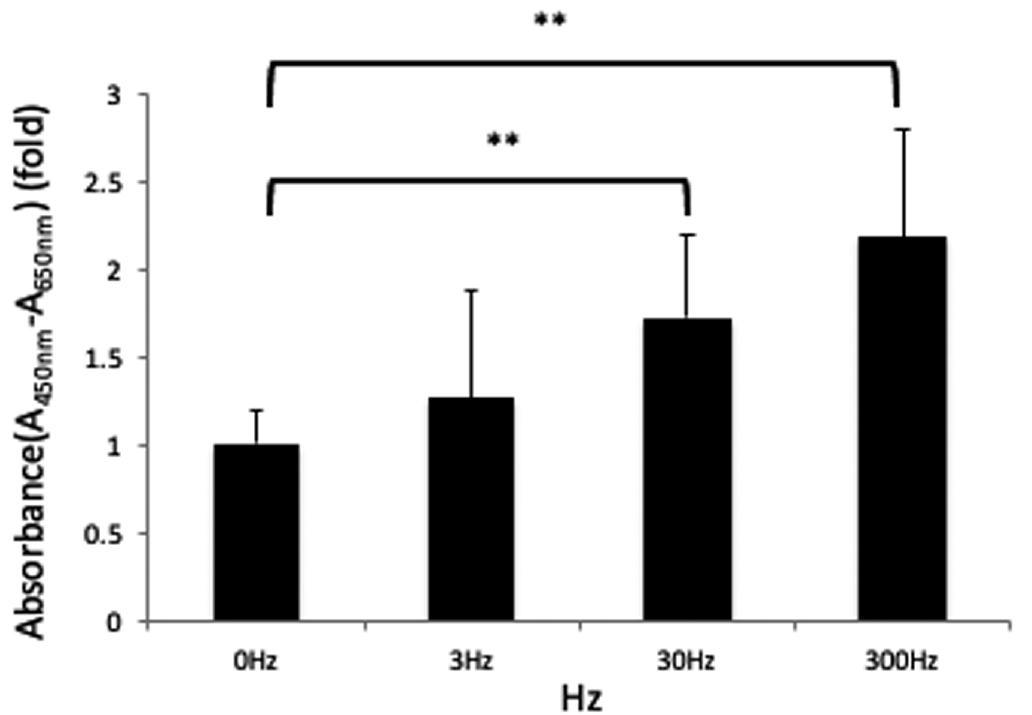
Figure 2. Cell Proliferation Assay. At 24 h after the application of vibration at 0, 3, 30, or 300 Hz, cells were evaluated with WST-1. Cell proliferation increased significantly at 30 and 300 Hz rather than at 0 Hz. Dunnet’s multiple comparison test for 30 Hz and 300 Hz to 0 Hz (**: p < 0.01).